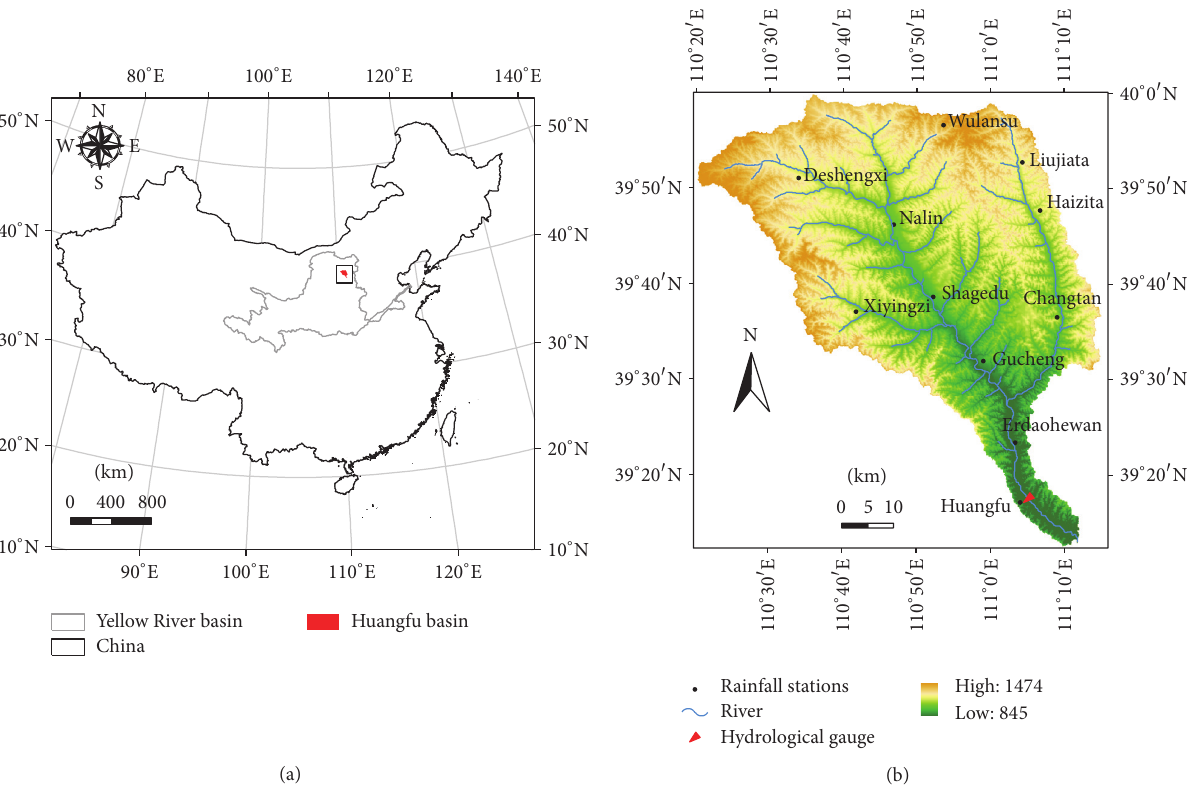
Figure 1: Location of thestudy area on the LoessPlateau, China ((a)map of China with study area; (b) location of study area with precipitation stations, hydrological